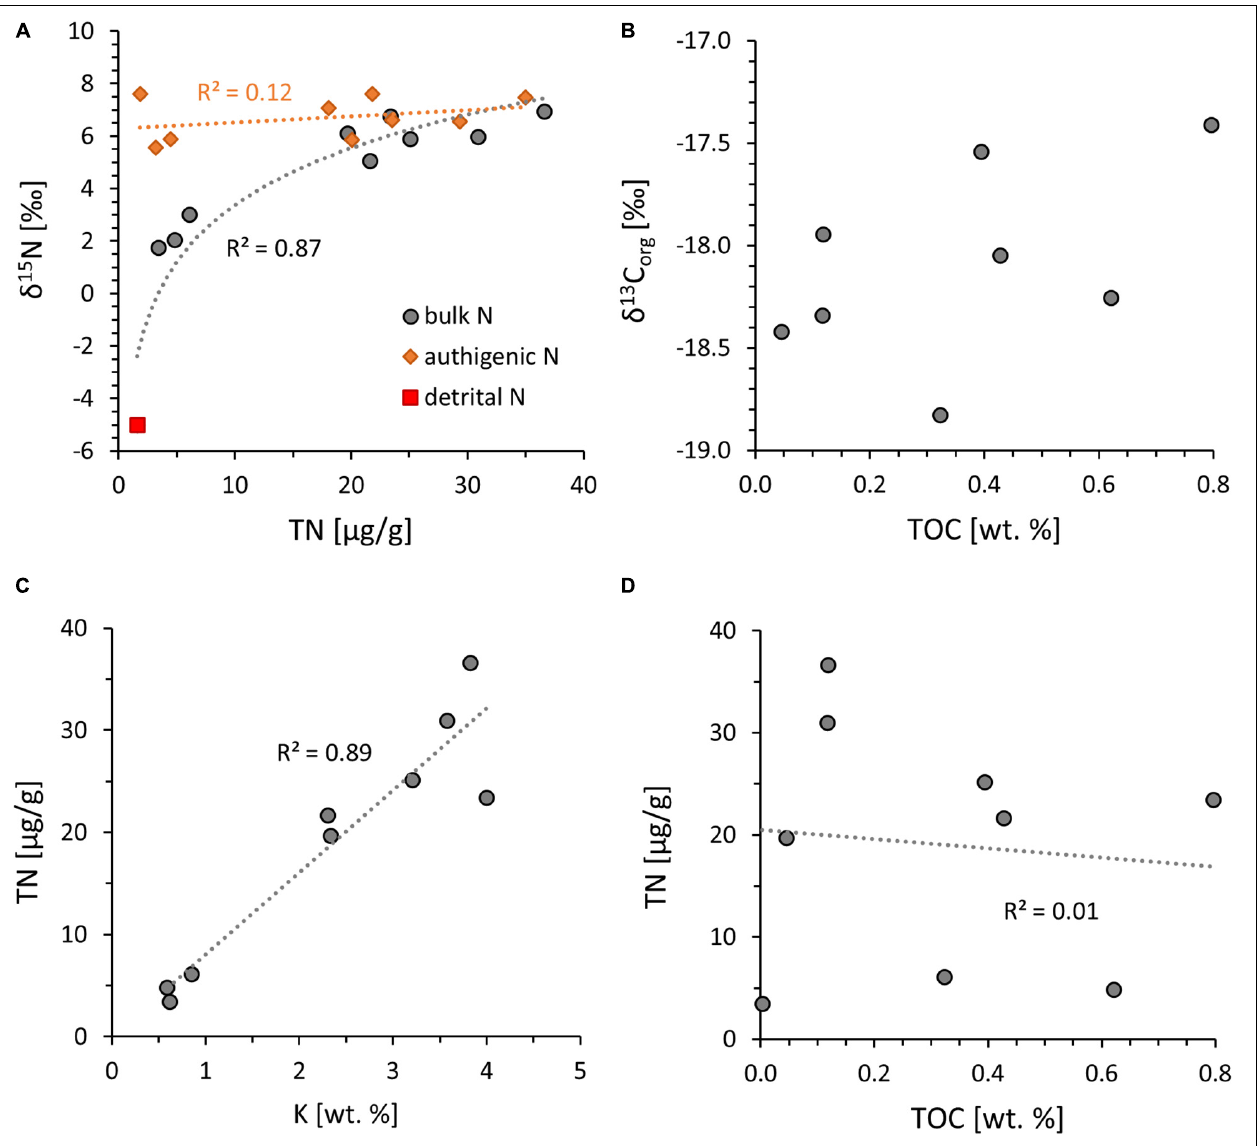
FIGURE 3 | Organic carbon and nitrogen data. (A) δ 15 N vs. total nitrogen (TN). Gray circles = measured data; red square = assumed detrital endmember; orange diamonds = calculated authigenic nitrogen component (see text for details). (B) δ 13 C org vs. total organic carbon (TOC). (C) Measured TN vs. K with strong covariance, indicating that most N is now bound to potassic minerals. (D) TN vs. TOC, showing no correlation, suggesting that only minor amounts of nitrogen are bound to organic